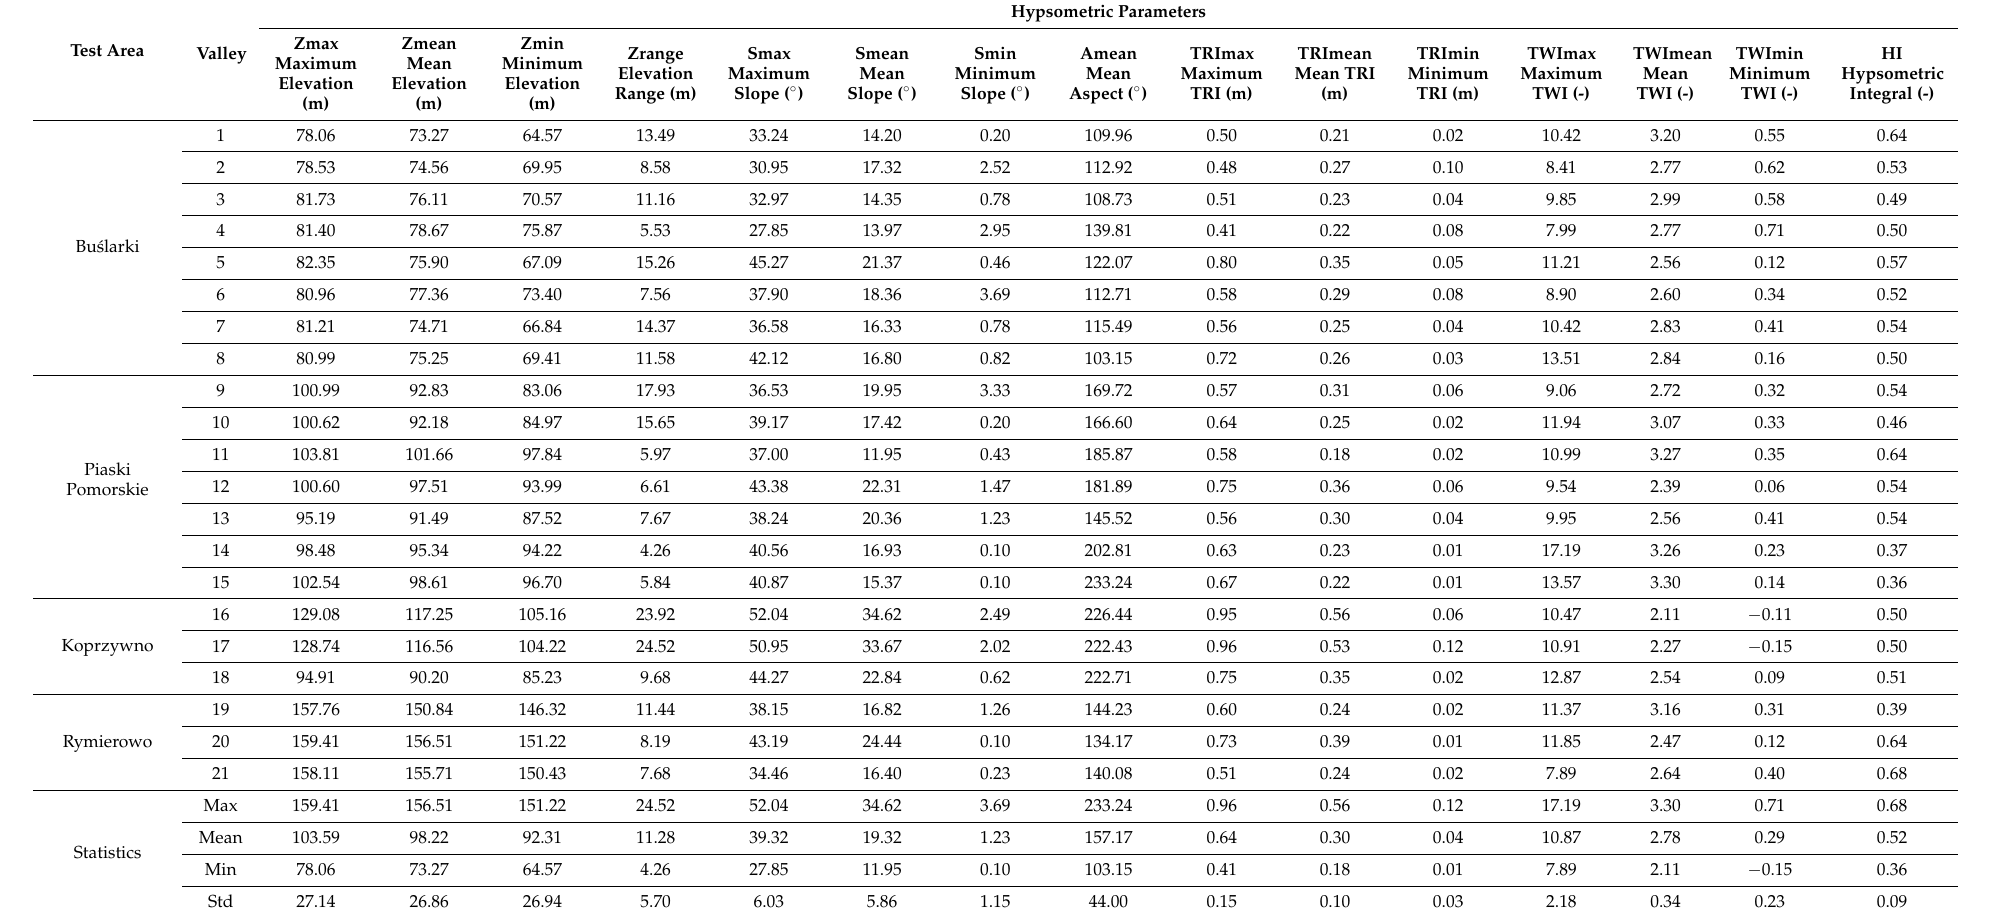
Table 6. Hypsometric parameters of the erosion-denudation